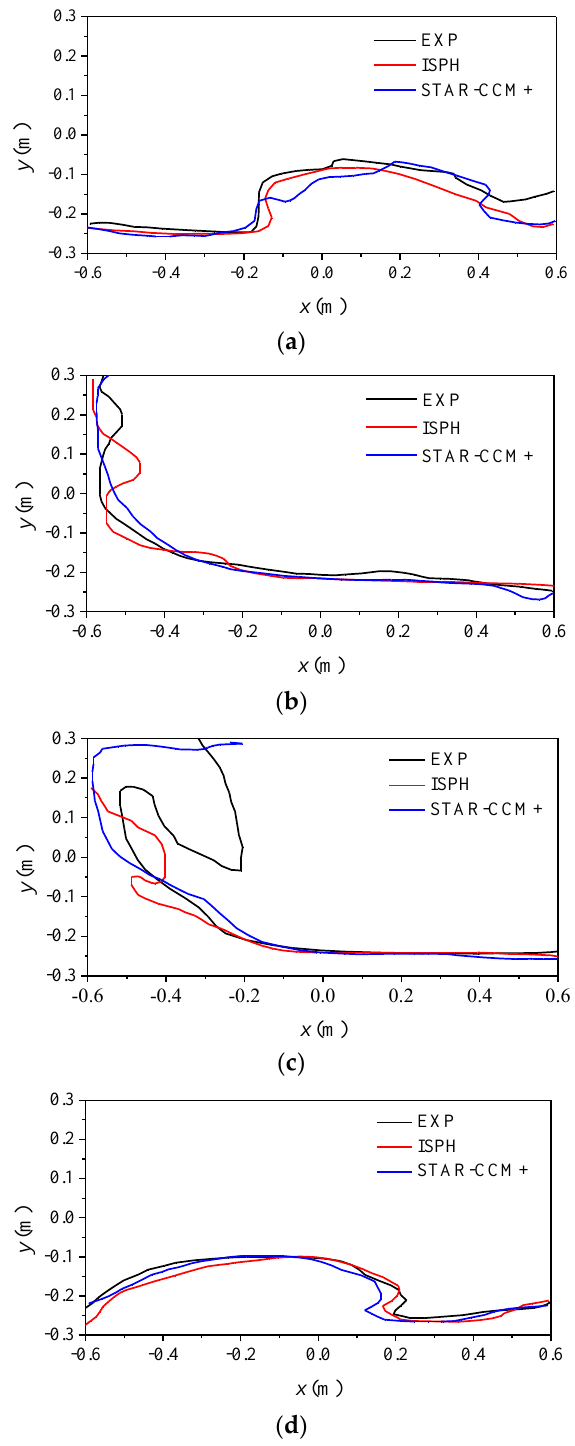
Figure 4. Comparisons of free surface profiles between ISPH, STAR-CCM+ numerical results and experimental data of Liao and Hu [27] at time: ( a ) 0 T ; ( b ) T /6; ( c ) T /3; ( d ) T /2.